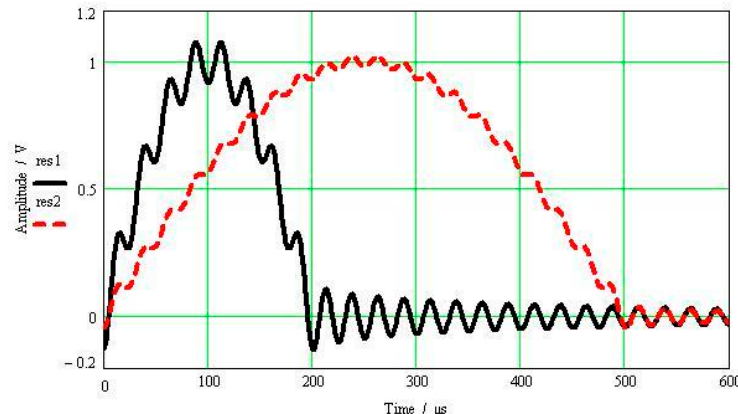
Figure 4. Sensor’s time domain response to the two pulsed excitations.